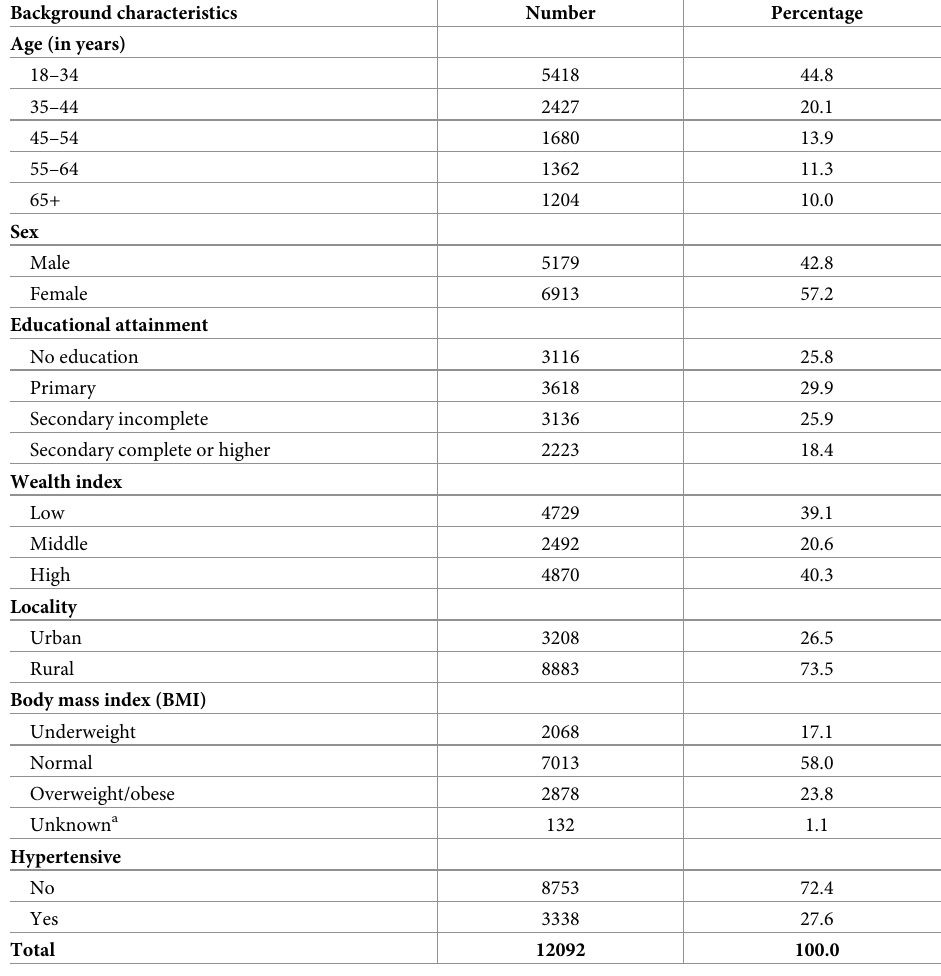
Table 1. Characteristics of the study population, Bangladesh